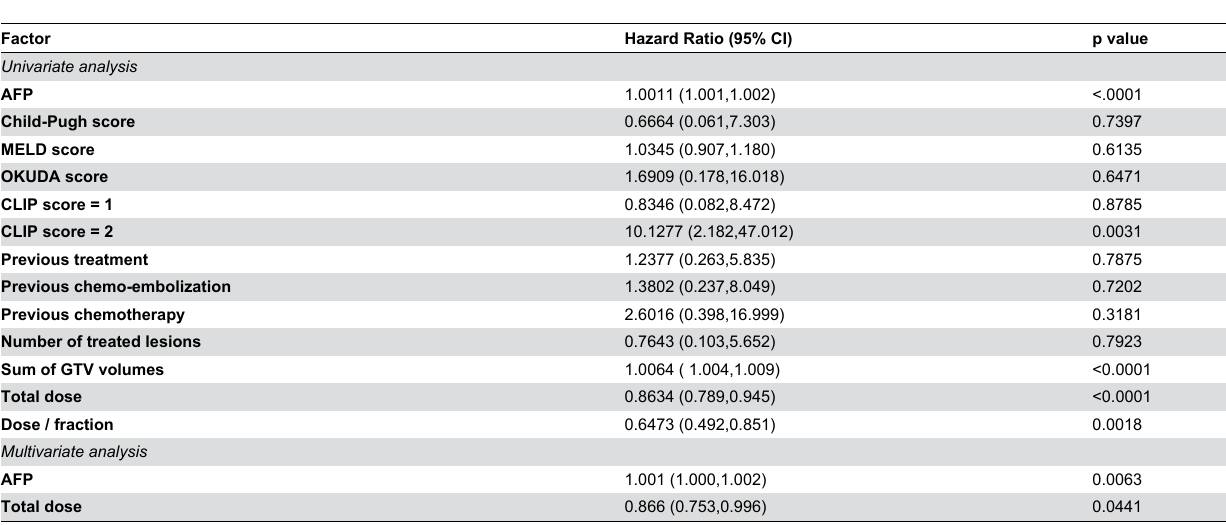
Table 4. Prognostic factors for local control (n=96 lesions).